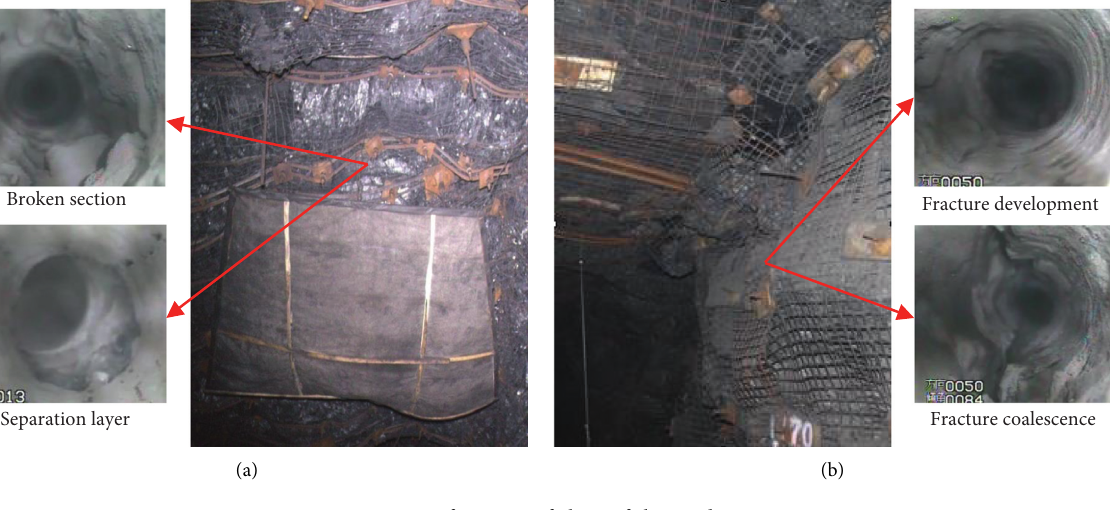
Figure 9: Deformation failure of the roadway.